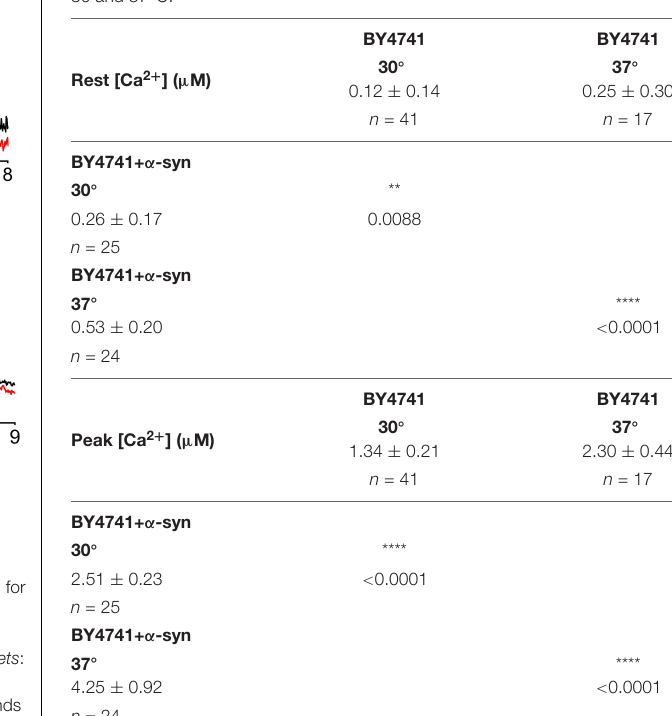
TABLE 3 | [Ca 2 + ] in determined at the end of the Ca 2 + -free period (Rest [Ca 2 + ]) (before membrane permeabilization) and the peak amplitude of the Ca 2 + release transient (Peak [Ca 2 + ]) in BY4741 cells and BY4741 cells overexpressing α -syn at 30 and 37 ◦